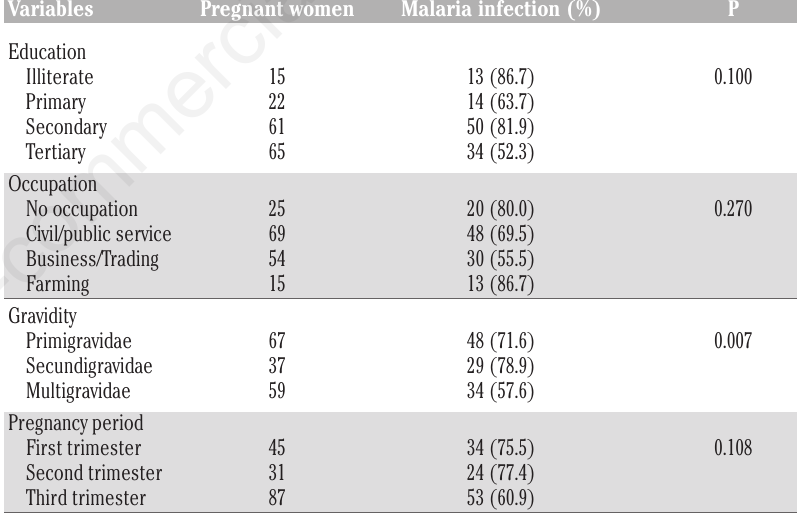
Table 1. Malarial infection in relation to education, occupation, gravidity and pregnan- cy period of pregnant women attending the antenatal clinic at the Federal Medical Centre, Makurdi, Benue State, Nigeria.